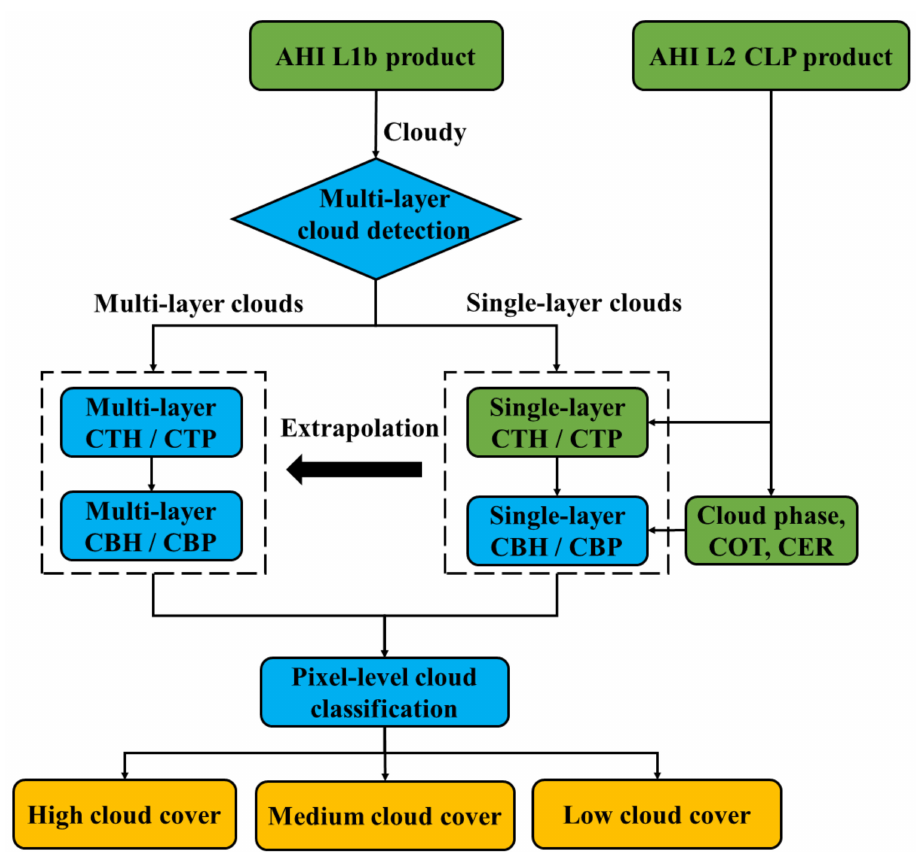
Figure 2. Algorithm workflow for estimating layered cloud cover based on Advanced Himawari